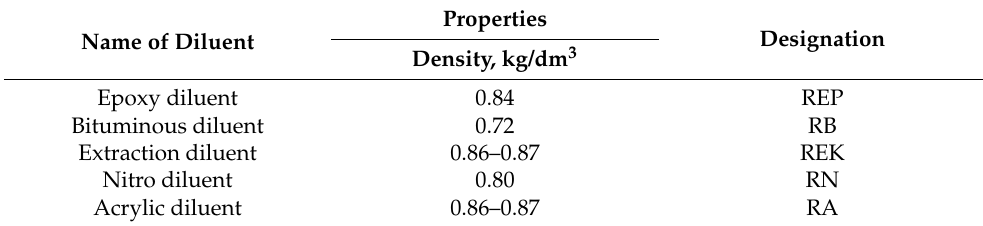
Table 1. Density and designations of the diluents under